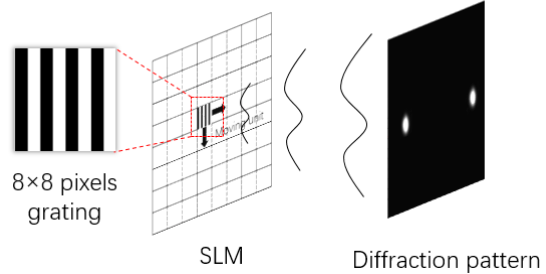
Figure 7. Pattern of single 8 × 8-pixel-grating unit uploaded for spatial nonuniformity measurement.